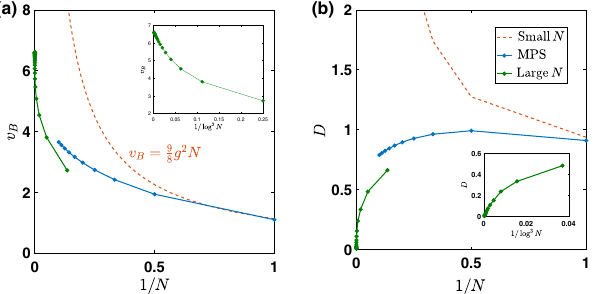
FIG. 3. Comparison between the butterfly velocity v the wave-front diffusion constant D (b) obtained from MPS simulation of the probability distribution to the small- N and large- N analysis. When N is small, v small- N result, relying on the local equilibrium assumption. As N increases, the approximation breaks down, and both v cross over to the large- N